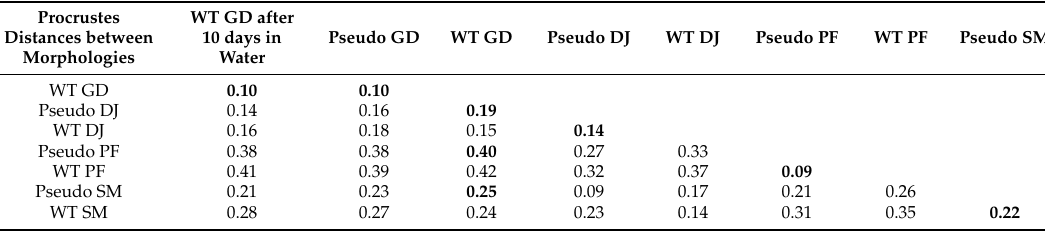
Table 1. Quantitative analysis of shape similarities between patterning outcomes and normal head shapes of three species.